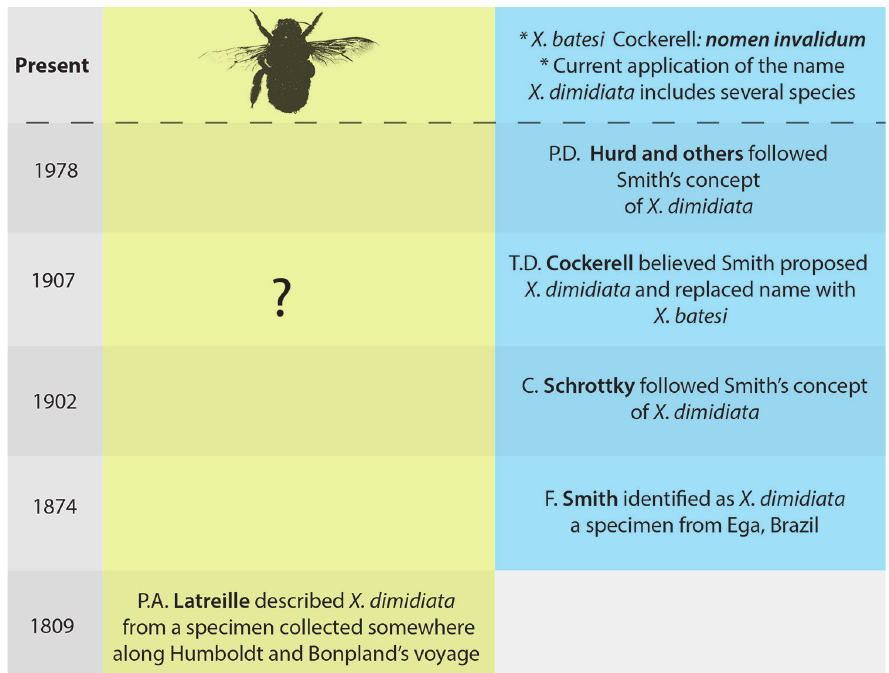
Figure 22. Schematic representation of the historical changes in the species concept and nomenclature surrounding X. dimidiata Latreille (see text for details). The yellow and blue columns each represent a species